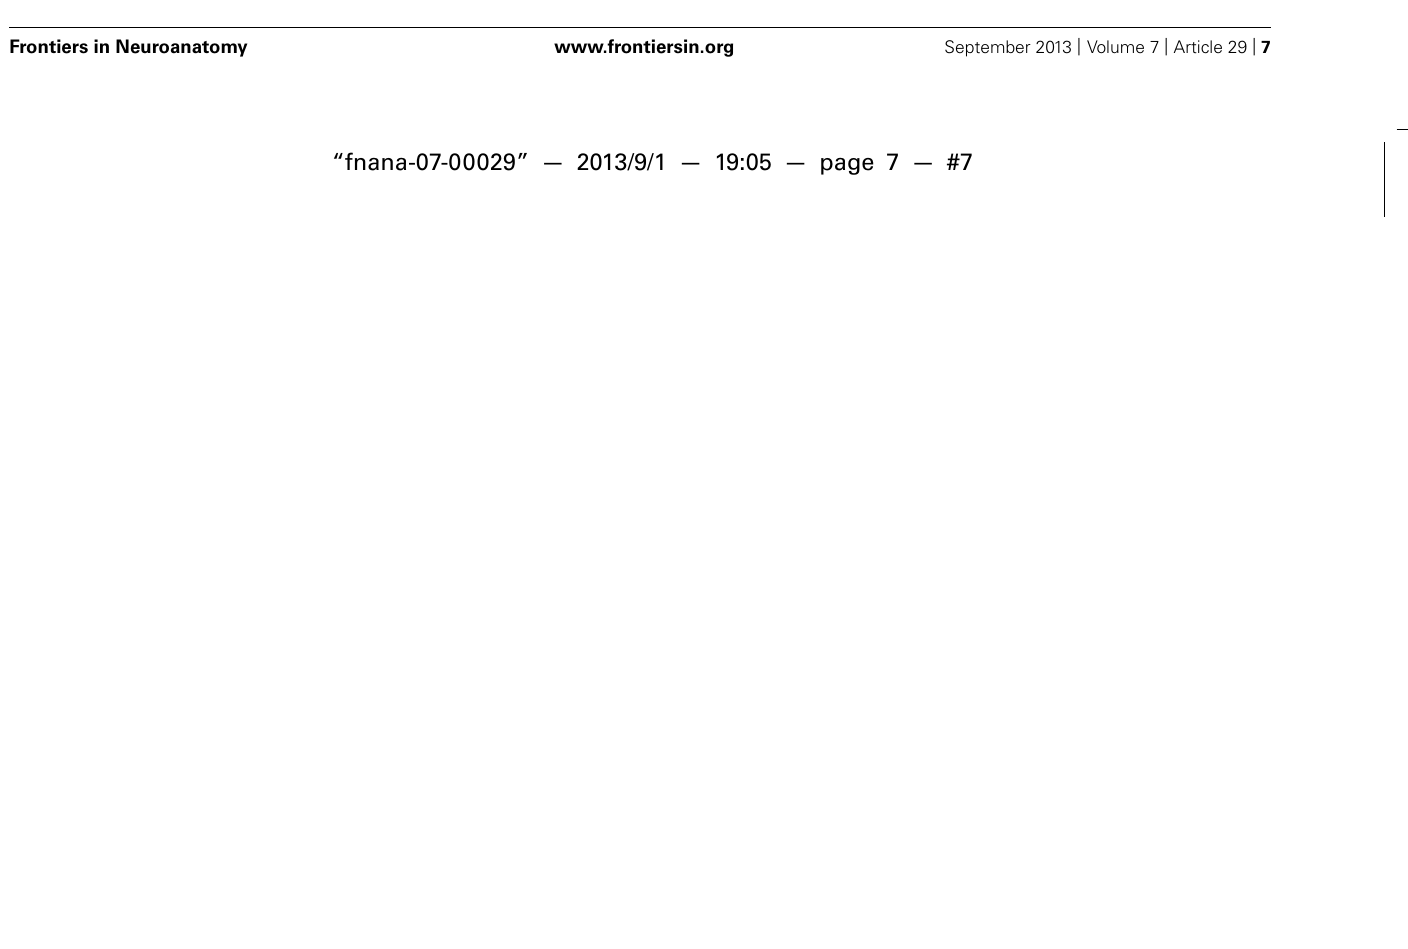
FIGURE 2 | Cellular development of cerebellum and components of the re-entrant cortico-cerebellar loop. (A) Schematic cross sectional view through the anlage of the cerebellum showing the relationship between rhombic lip (rl), ventricular zone (vz), and roof plate (rp) of the fourth ventricle. Adult morphological layering ( Figure 1 ) is the product of two major migration pathways.The vz gives rise to GABA-ergic radially dispersed Purkinje cells ( oc ).The rl generates glutamatergic deep cerebellar nucleus ( dcn ) neurons and granule cell precursors of the external germinal layer ( egl ), which migrate tangentially from the rl in sub-pial streams. (B) Postnatally, the egl proliferates under the influence of Purkinje cell-derived Shh. Postmitotic glutamatergic granule cells migrate radially from the EGL to internal granule layer ( igl ). In mutants where Purkinje cells are deleted, or in which Shh is depleted, or